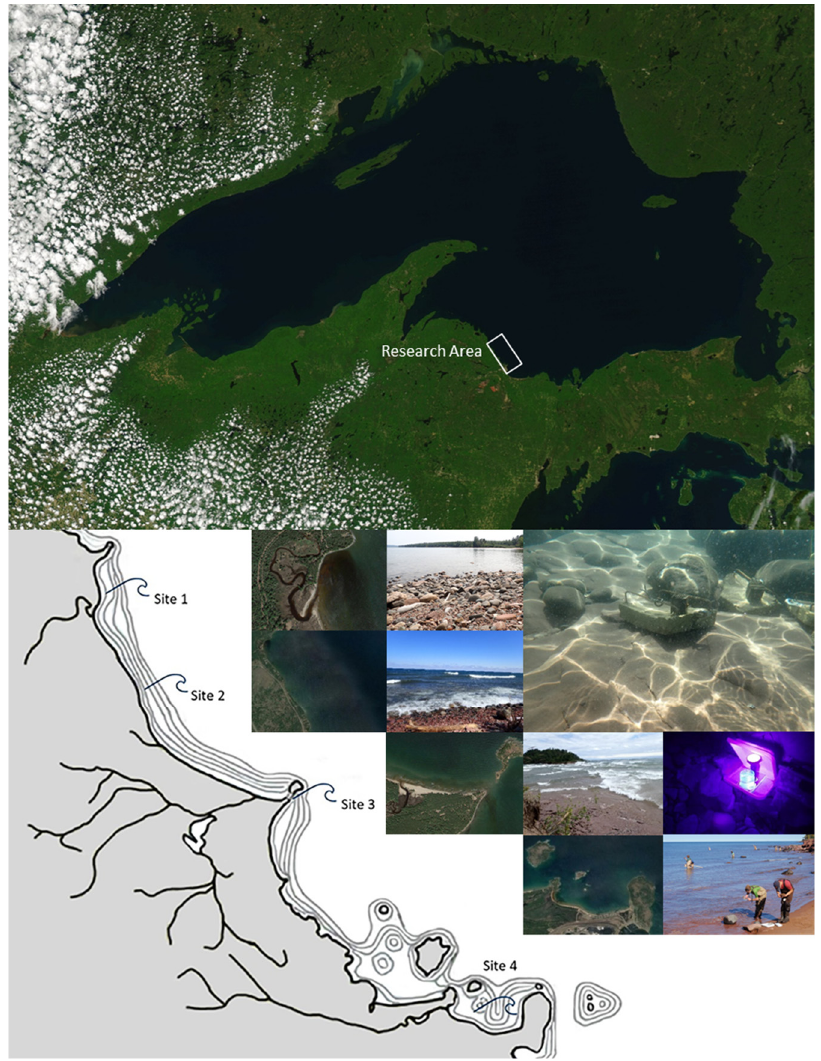
Figure 2. Research area, site locations, and caddisfly sampling equipment. Images clockwise from top: Lake Superior MODIS image showing location of research area [52]; deployed samplers underwater showing sandstone and boulder lake bottom habitat; UV light adult caddisfly sampler; research area showing location, satellite images [53], and photographs of the four sites. Detailed site descriptions are presented in Supplementary Materials S1: Site Descriptions.